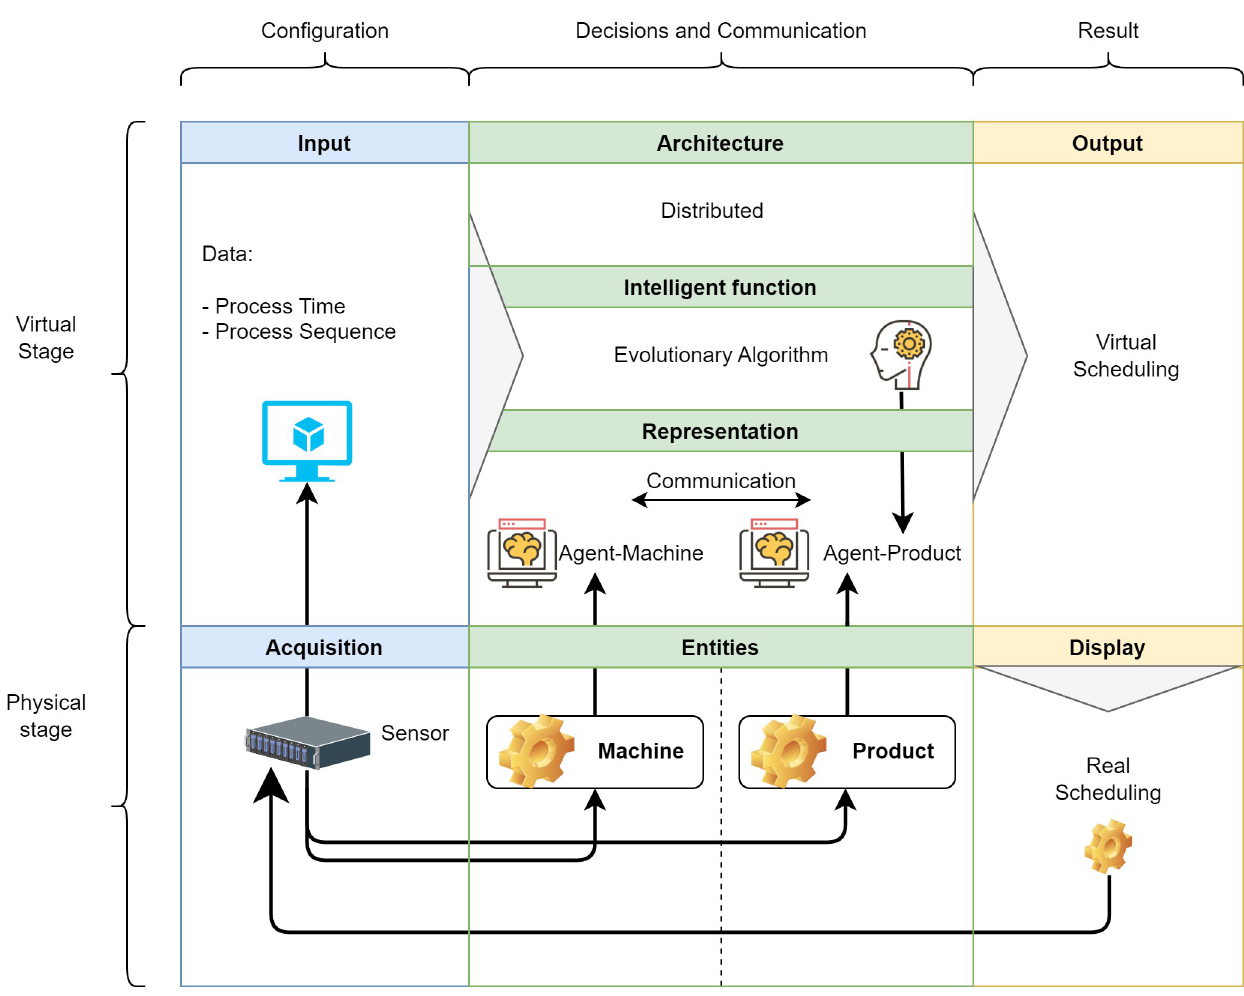
Fig 2. Schematic presentation of